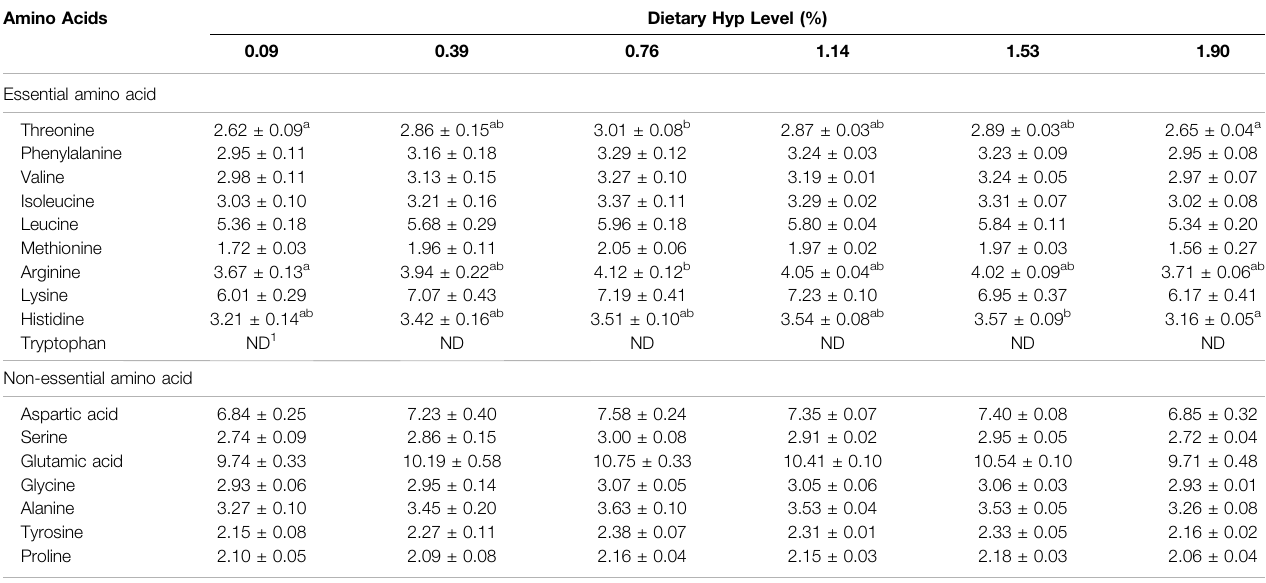
TABLE 6 | Amino acid pro fi le in dorsal muscle of ITCC fed with different experimental diets for 8 weeks (% dry matter). Amino Acids